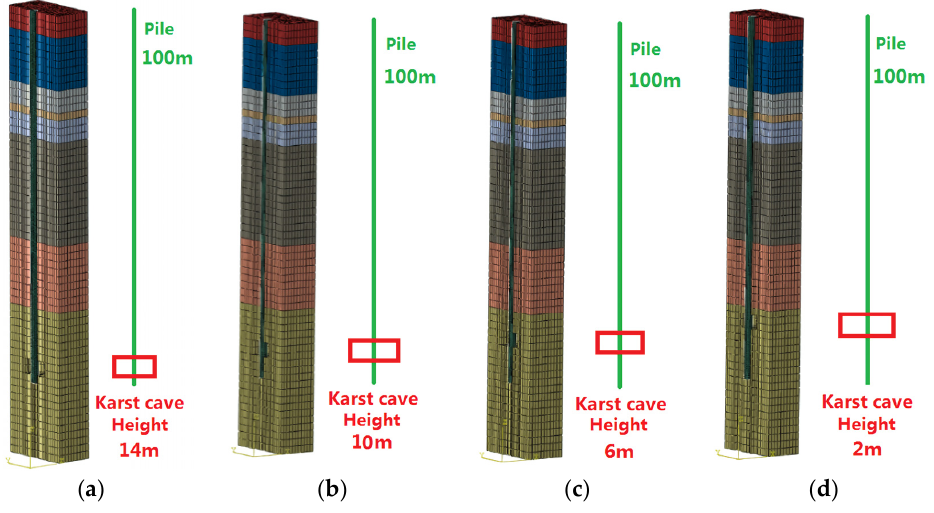
Figure 5. Schematic diagram of the finite element model of the rock-socketed piles with different cave roof heights. ( a ) Height 14 m, ( b ) 10 m, ( c ) 6 m, and ( d ) 2 m. cave roof heights. ( a ) Height 14 m, ( b ) 10 m, ( c ) 6 m, and ( d ) 2